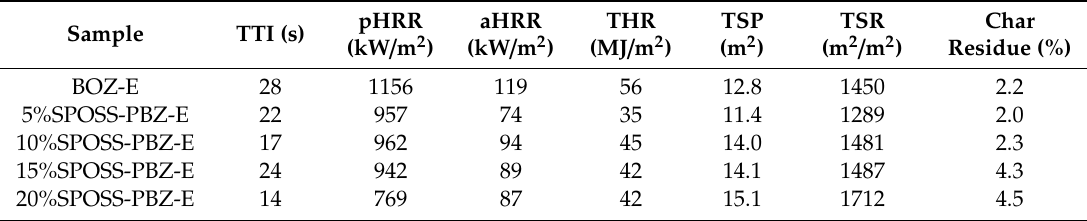
Table 5. Cone calorimeter data for the SPOSS-BOZ-E nanocomposites. TTI, time to ignition; pHRR, peak heat release rate; aHRR, average HRR; THR, total heat release; TSP, total smoke production; TSR, total smoke